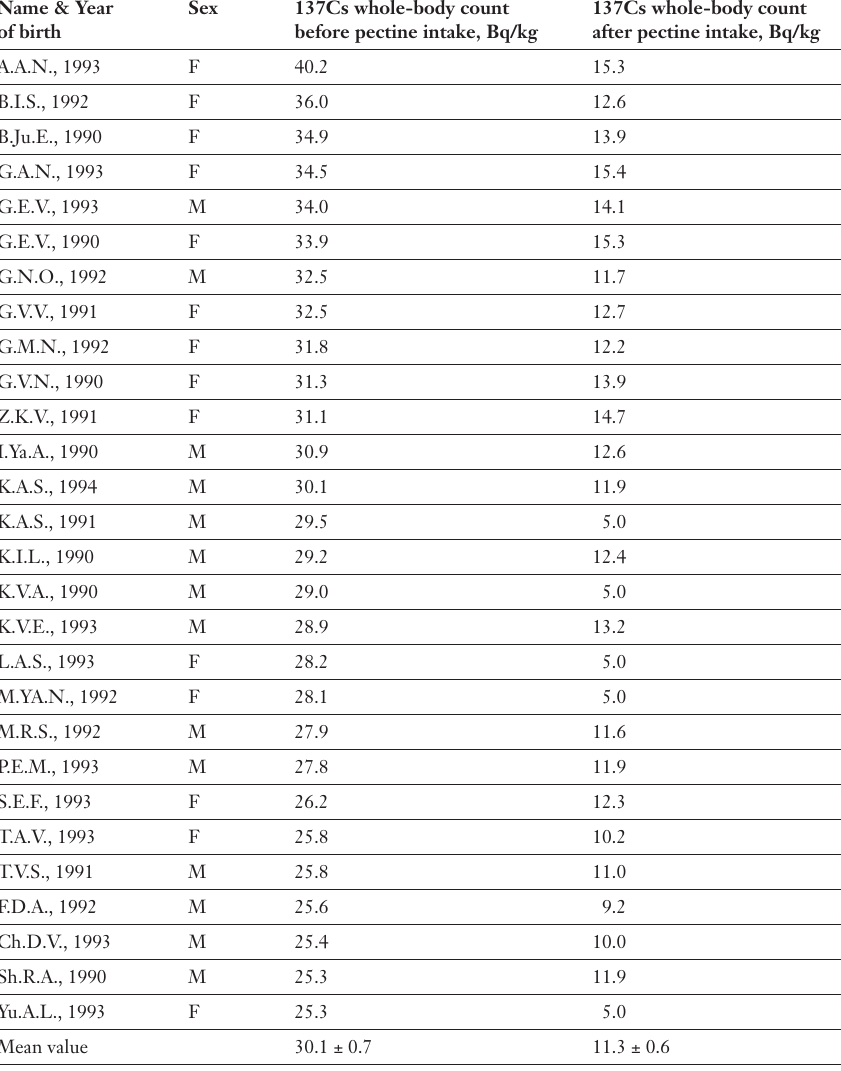
Double-blind com- parison of the 137Cs whole-body count (Bq/kg) of school- children, before and after a 3-week cure with simultaneous one-month stay in a sanatorium, with a radiologically clean environment and “clean” food. Com- parison of the 137Cs whole-body count (Bq/kg bodyweight) in children before and after a 3 week pectine